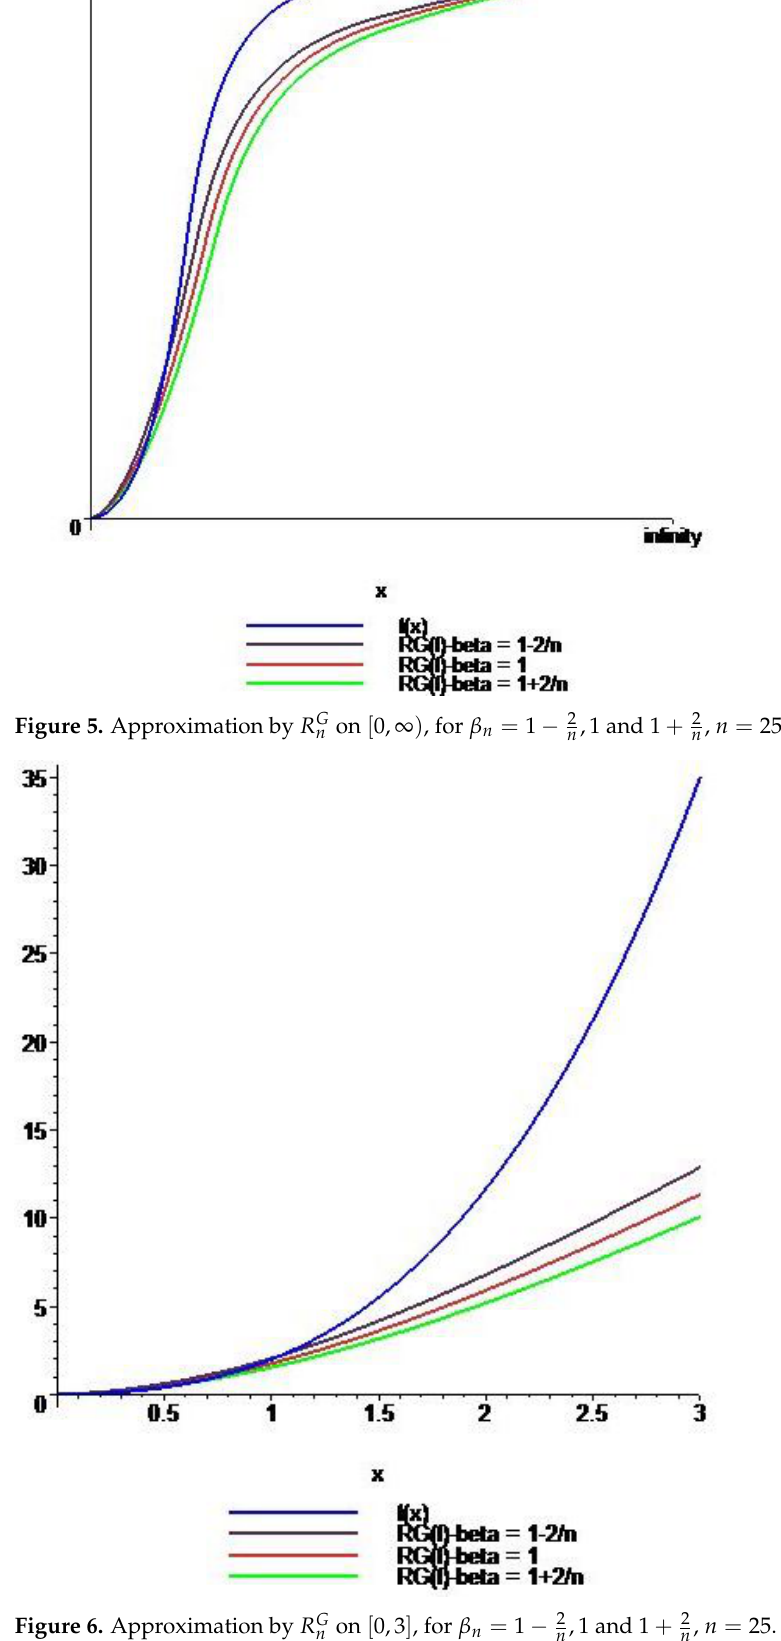
,1 and 1 + 2 , n = n n